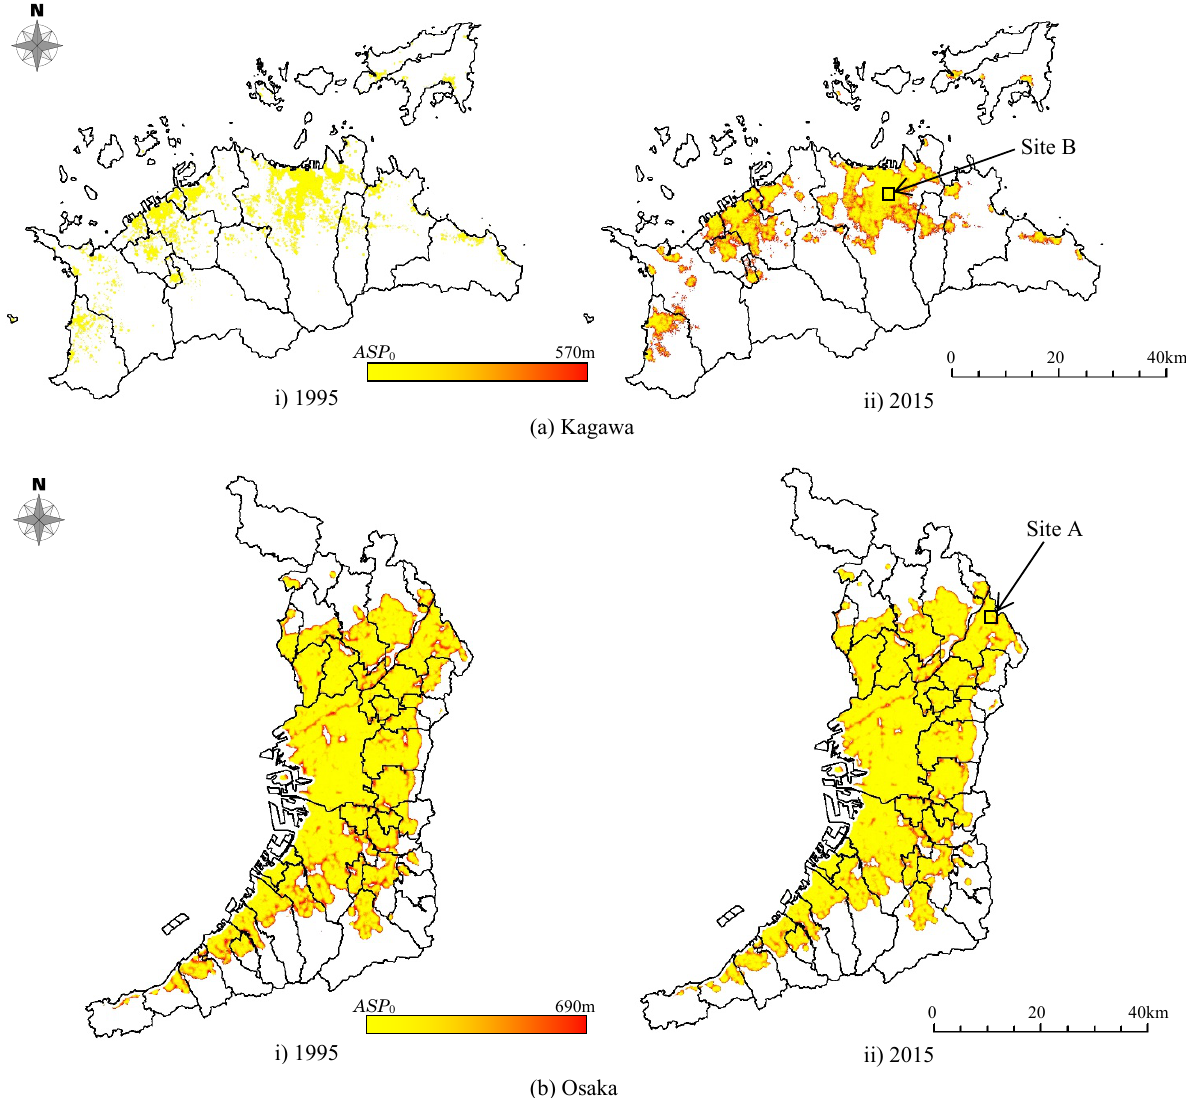
Figure 5 . Results of the spatial analysis we have developed: distributions of